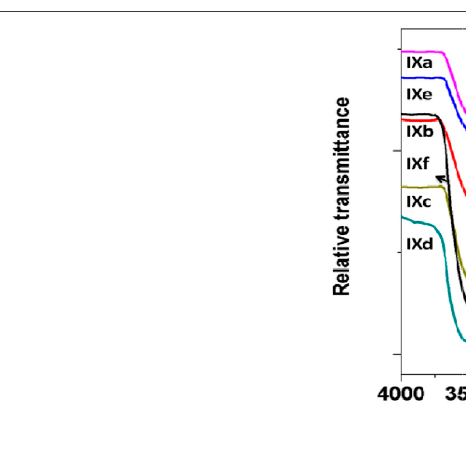
FIGURE 5 | FT-IR spectra of ( IXa-f ) phthalocyanines.